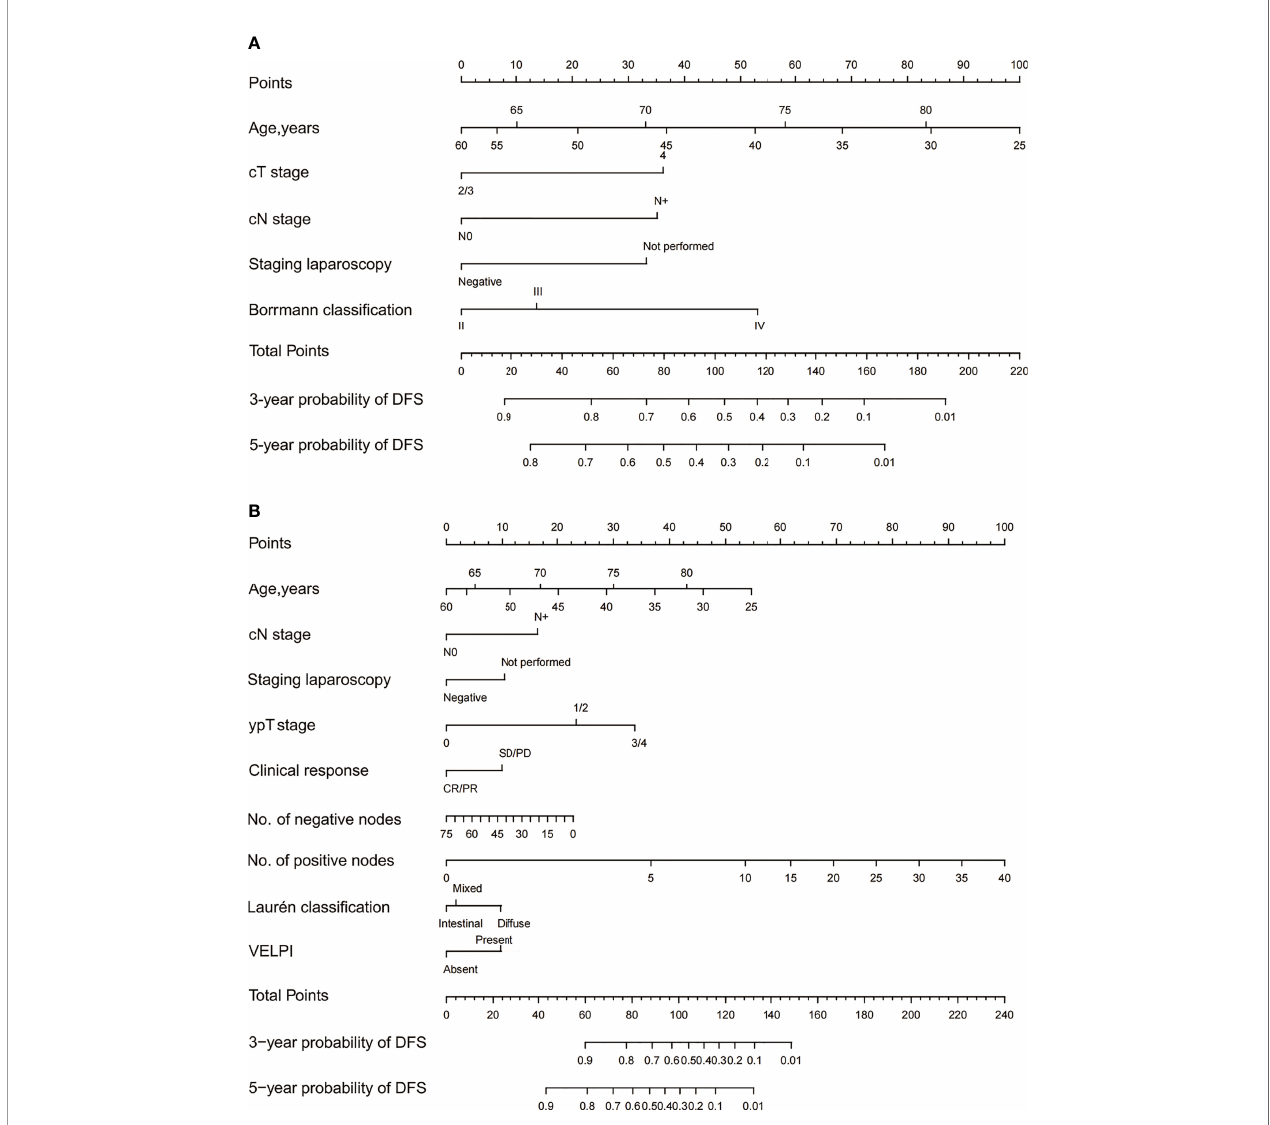
FIGURE 2 | The 3- and 5-year DFS of Siewert Type II/III AEG patients were predicted by the baseline nomogram (A) and post-therapy nomogram (B) . Each variable in the model corresponded to a score, and all the scores were summed to obtain a total score corresponding to the probability of free-recurrence at 3 and 5